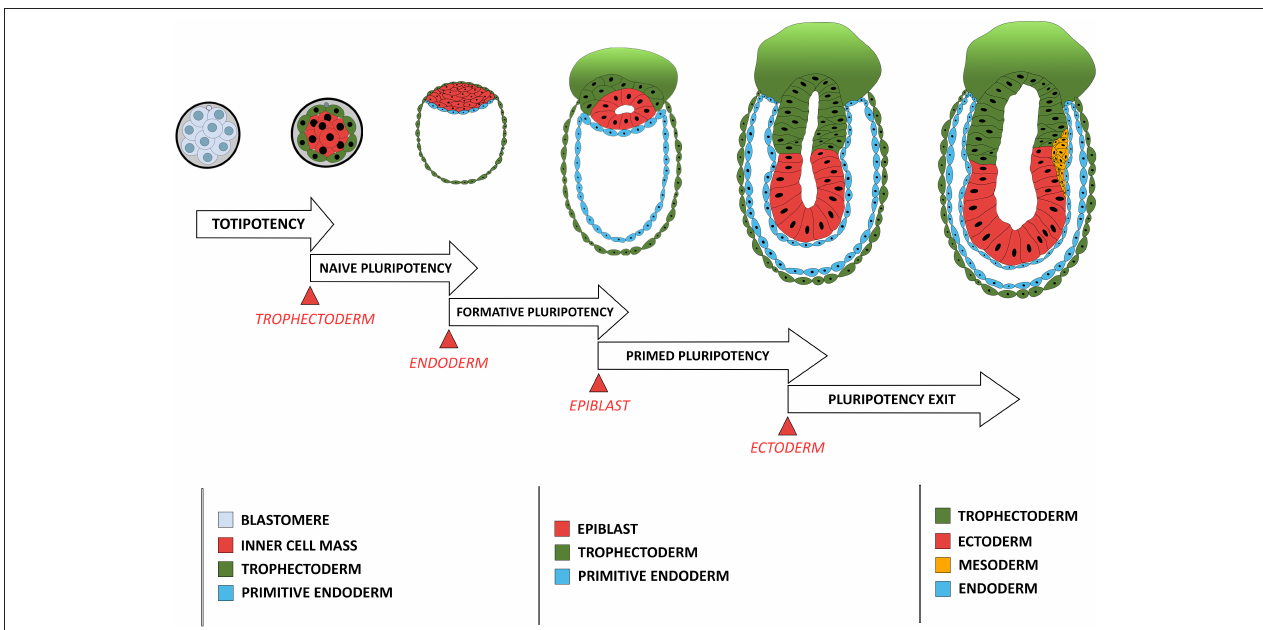
FIGURE 1 | Comparison between the developmental stage of a mouse embryo and the concomitant restriction in cellular potency. Each restriction in cellular potency is associated with the creation of an embryonic structure through an epithelialization process: the totipotency is lost when the trophectoderm epithelializes; the naïve pluripotency loss corresponds to the epithelialization of the endoderm; the formative state loss is concomitant with the epithelialization of the epiblast; and the primed pluripotency loss corresponds to the acquisition of a fully epithelial organization by the epiblast leading to pluripotency exit, a stage poised for differentiation including ectoderm-fated epithelium formation and mesendoderm induction through another round of EMT.